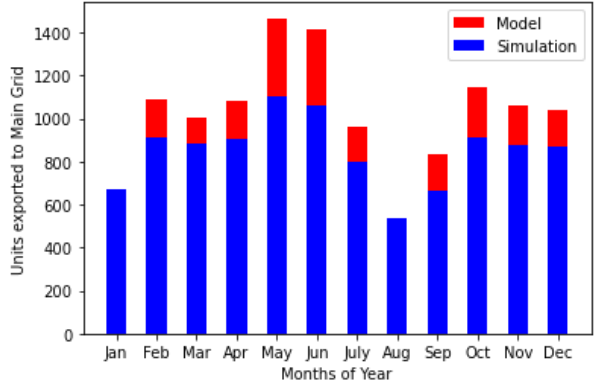
Figure 9. Monthly electricity unit savings.